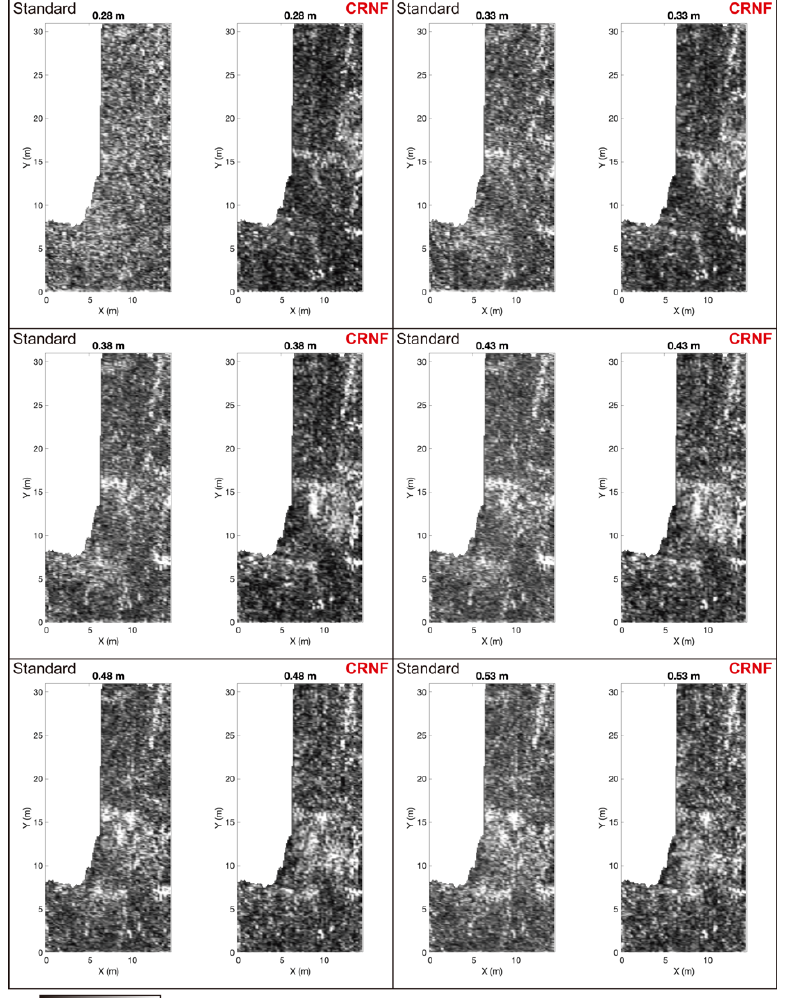
Figure 10. Comparison between the same GPR depth-slices without (Standard) and with spectral filtering (CRNF). The CRN filtered results allow us to observe that there was an increase in the contrast between the background and the coherent reflections of buried structures.